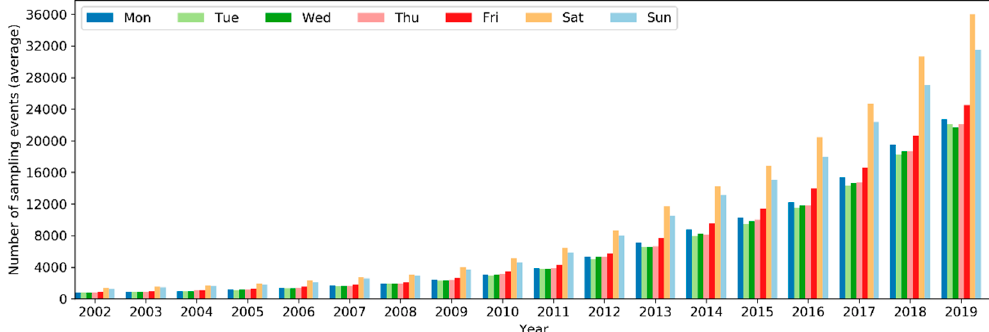
Figure 6. Percentage of sampling events in each month relative to the yearly total number of events.